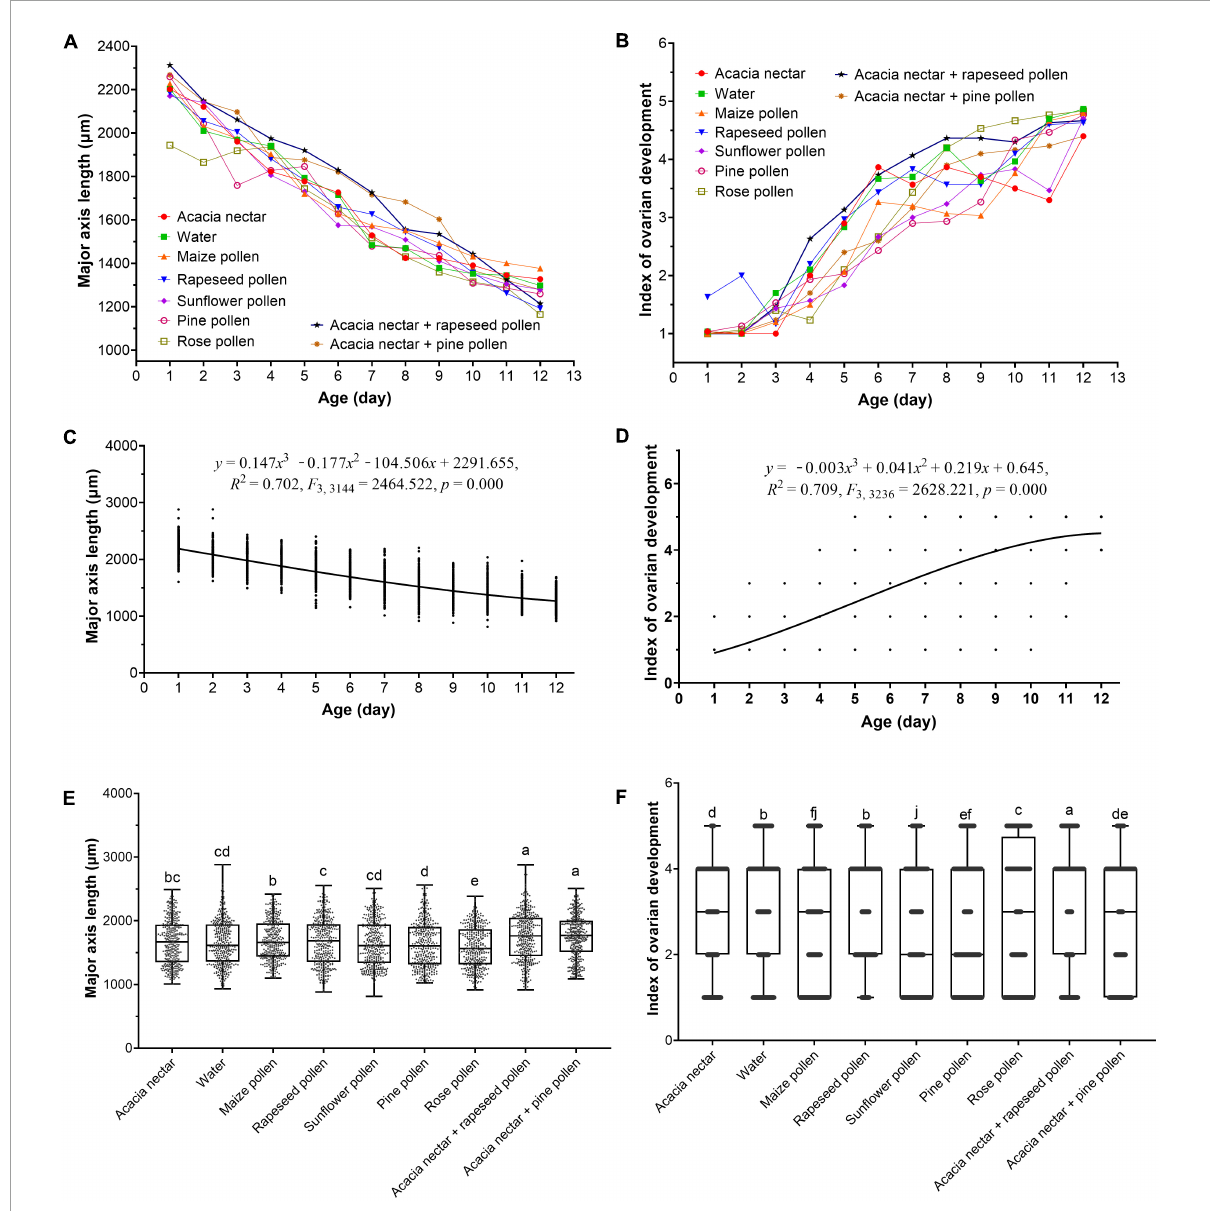
FIGURE5 Effect of age and diet on testis size (A,C,E) and ovarian development level (B,D,F) of Mythimna separata . In (C,D) , means ± SE are shown. In (E,F) , the bottom and top of the black box indicate the first and third quartile values, respectively; the horizontal solid line shows the median for each category; bars indicate the maximum and minimum. Different lowercase letters above the bar indicates a significant difference (two-way ANOVA, Duncan’s MRT; p <